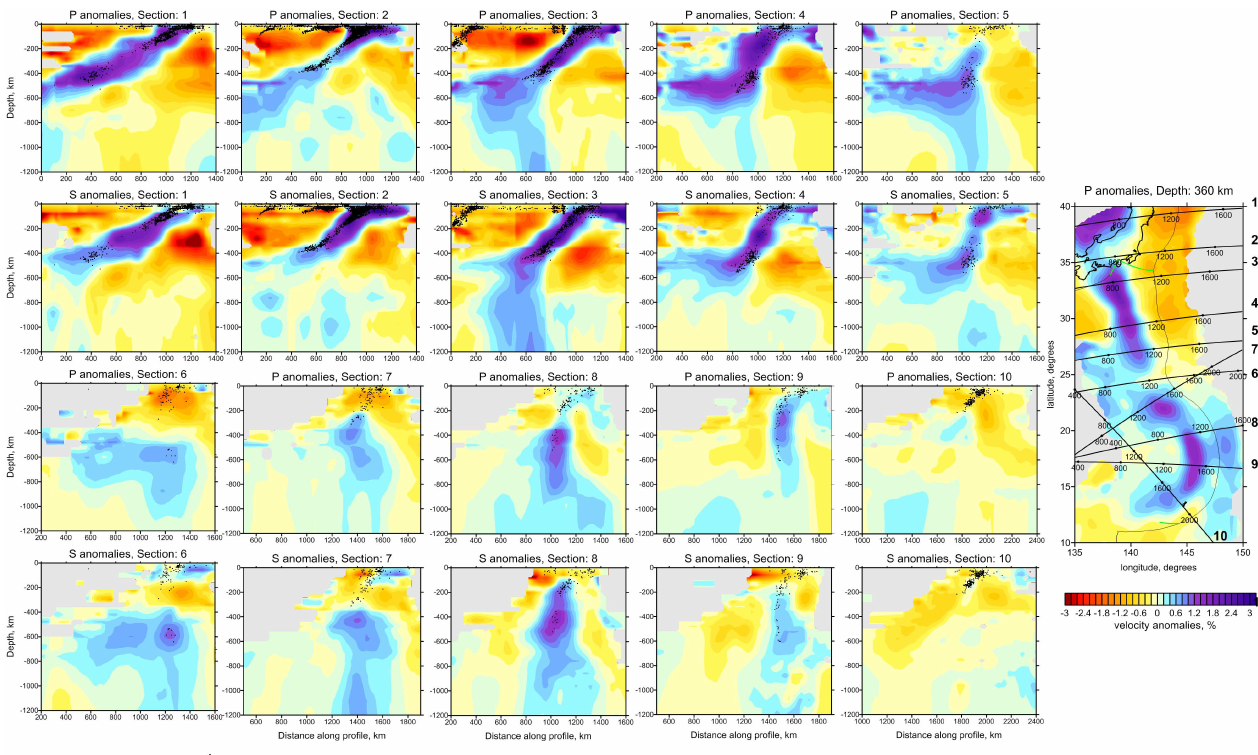
Fig. 4. The results of real data inversion. P-and S-anomalies are presented in vertical cross-sections across the Izu-Bonin-Mariana arc; locations of sections are shown in the map on the right. Black dots are the earthquake hypocentres located at a distance of no more than 50km from the profile.